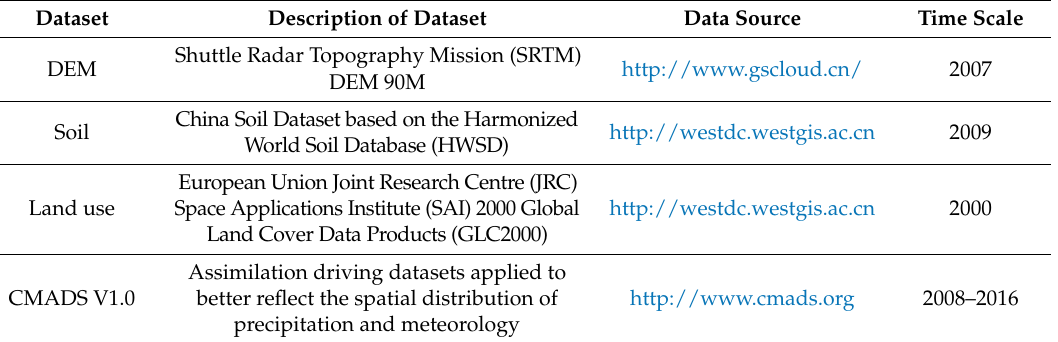
Table 1. A description of the data used for this study.